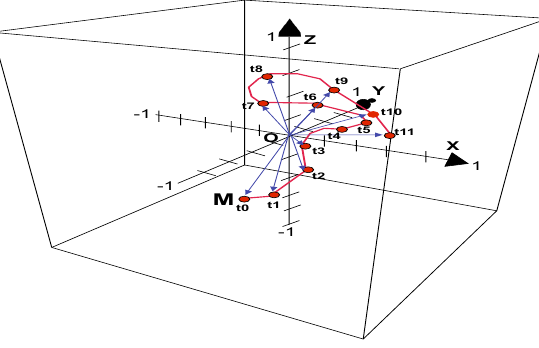
Figure 3. Hodograph of the vector function (cid:126) U ( t ) and dot M in the fuzzy vector space